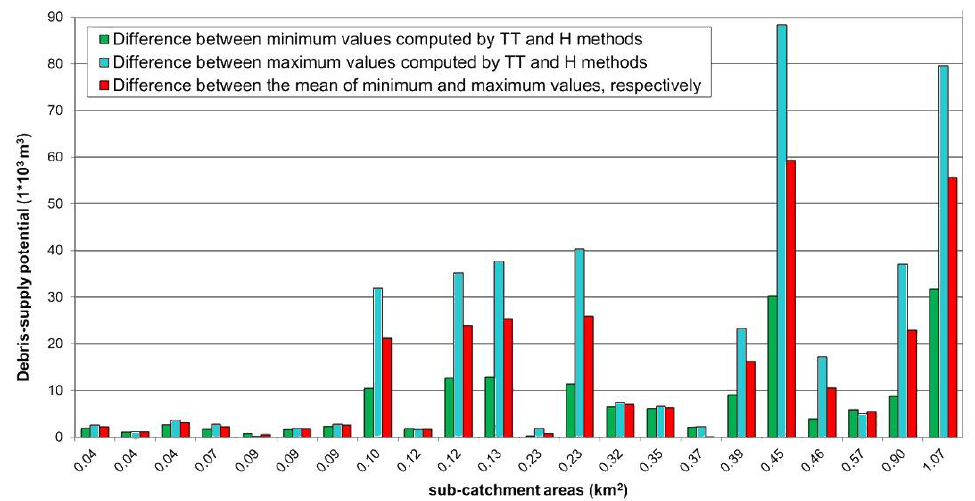
Figure 17. Comparison between the numerical discrepancies of the values of potential debris supply for every subcatchment in relation to its area. Such analysis was carried out to evaluate which pair of values (max, min and average), obtained with the (TT) and (H) methods [47,48,50], could have the best fit. It results that the discrepancy between the minimum values offer a more significant result, with a discrepancy of fewer than 10,000 cubic meters on average.